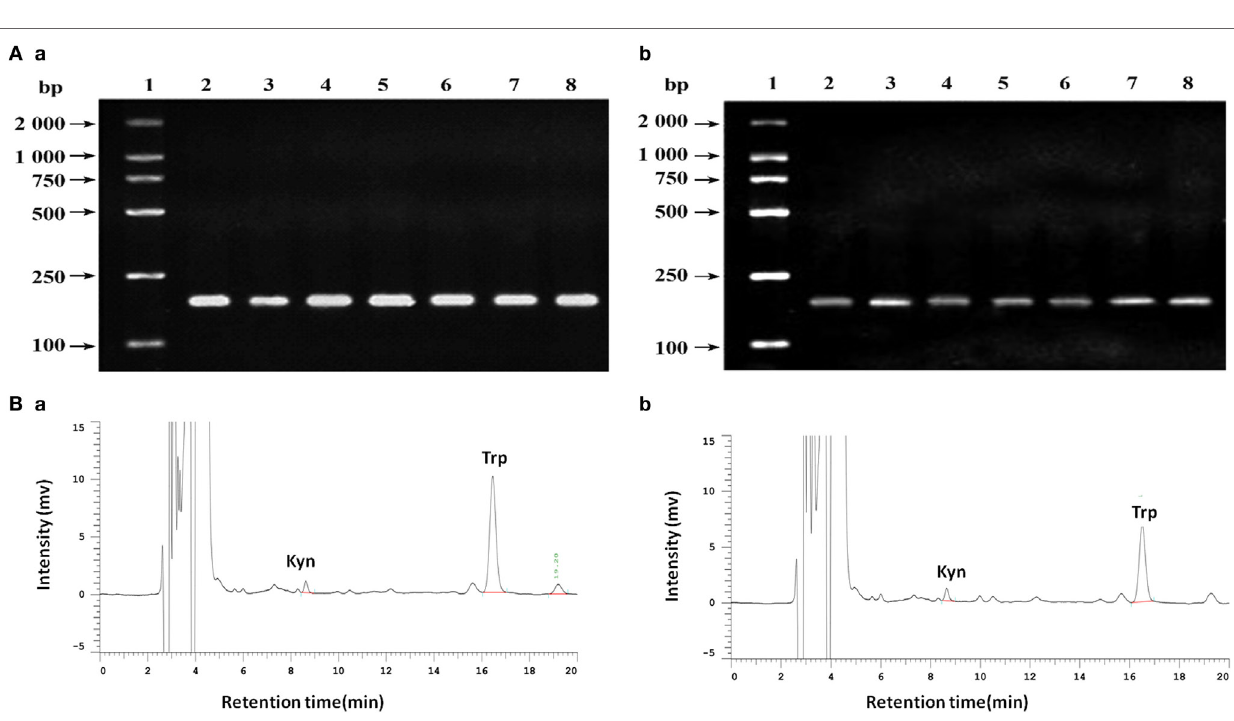
FigUre 5 | (a) Analysis of indoleamine 2,3-dioxygenase (IDO) expression in different cell lines by agarose gel electrophoresis. (a) β -actin; (b) IDO. 1. DNA marker DL2000; 2. MDA-MB-231; 3. MDA-MB-435S; 4. MDA-MB-453; 5. SK-Br-3; 6. ZR-75-1; 7. T47D; 8. MCF-7. (B) Analysis of tryptophan and kynurenine by high performance liquid chromatography using reversed phase C18 columns (5 µm, 4.6 mm × 150 mm, Kromasil). Retention times for kyn and try were 8.65 and 16.51 min, respectively. The concentration of tryptophan and kynurenine in MCF-7 cells the culture supernatant were 2.070 ± 0.604 mg/L and 0.207 ± 0.012 mg/L (b), while 4.707 ± 0.051 mg/L and 0.193 ± 0.006 mg/L in no cell culture supernatant